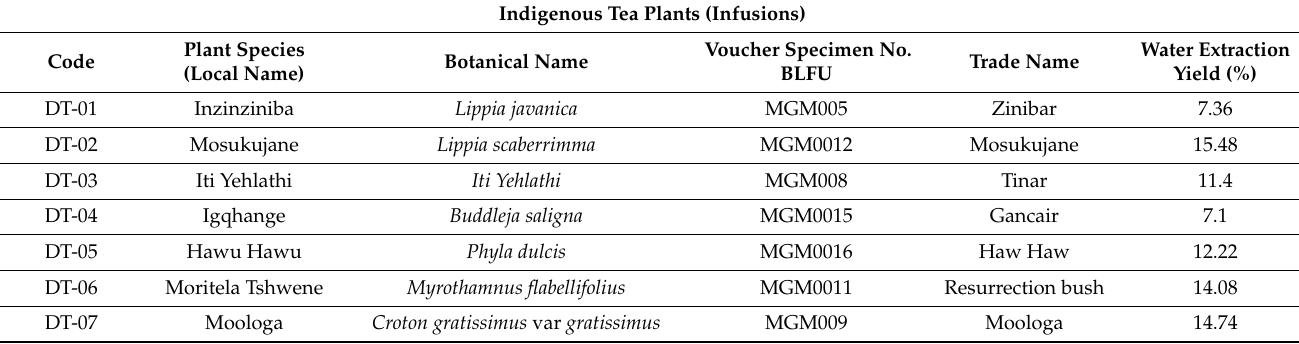
Table 2. Indigenous tea plants (Code: DT-01 to DT-07) from different regions of South Africa. Voucher specimen. Trade names and infusion